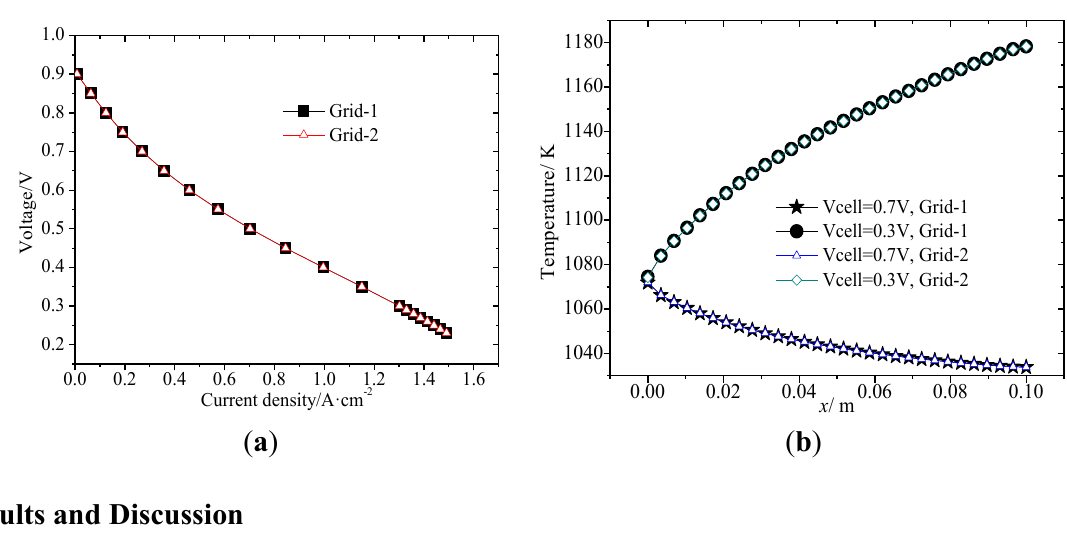
Figure 4. Grids independence test: ( a ) I - V ; and ( b )